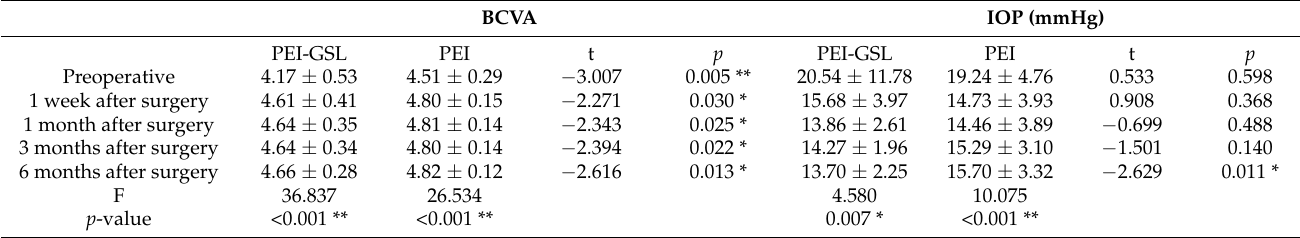
Table 2. Comparisons of BCVA and IOP between PEI-GSL and PEI groups.